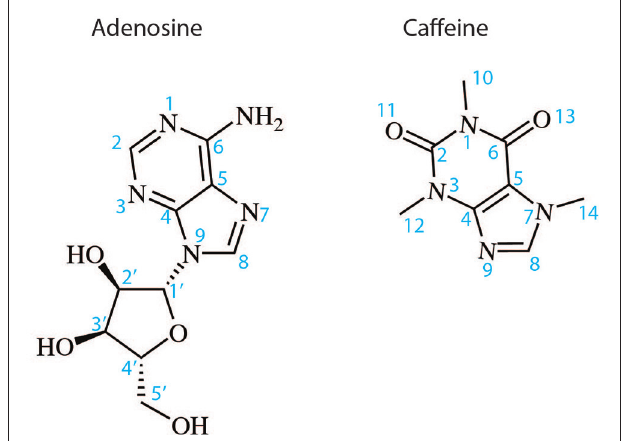
FIGURE 2 | Two dimensional structures of the endogenous A 2A R agonist adenosine and the naturally occurring antagonist caffeine. The atom numbering indicated is used in the text to describe the binding of these ligands and their derivatives to A 2A